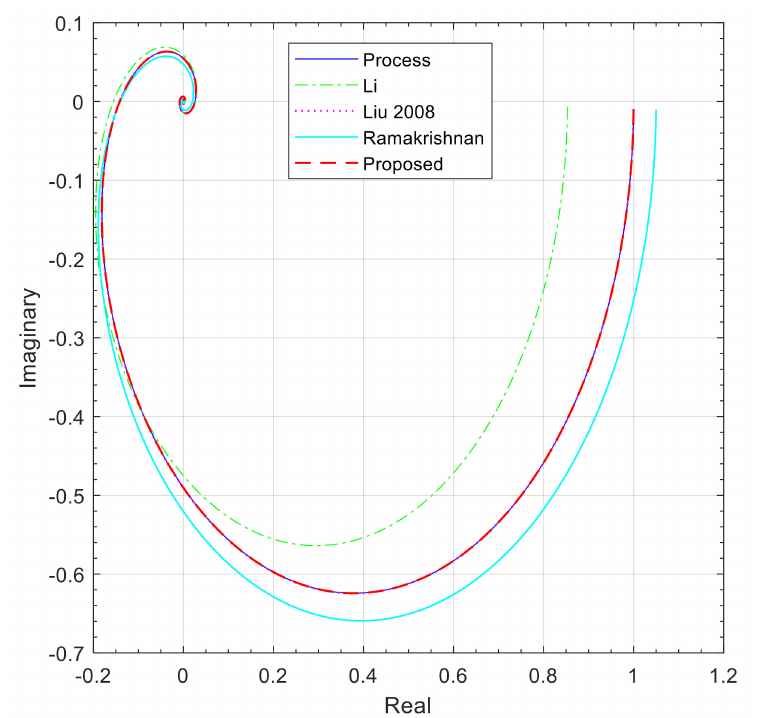
Figure 20. The Nyquist plots for process G P5